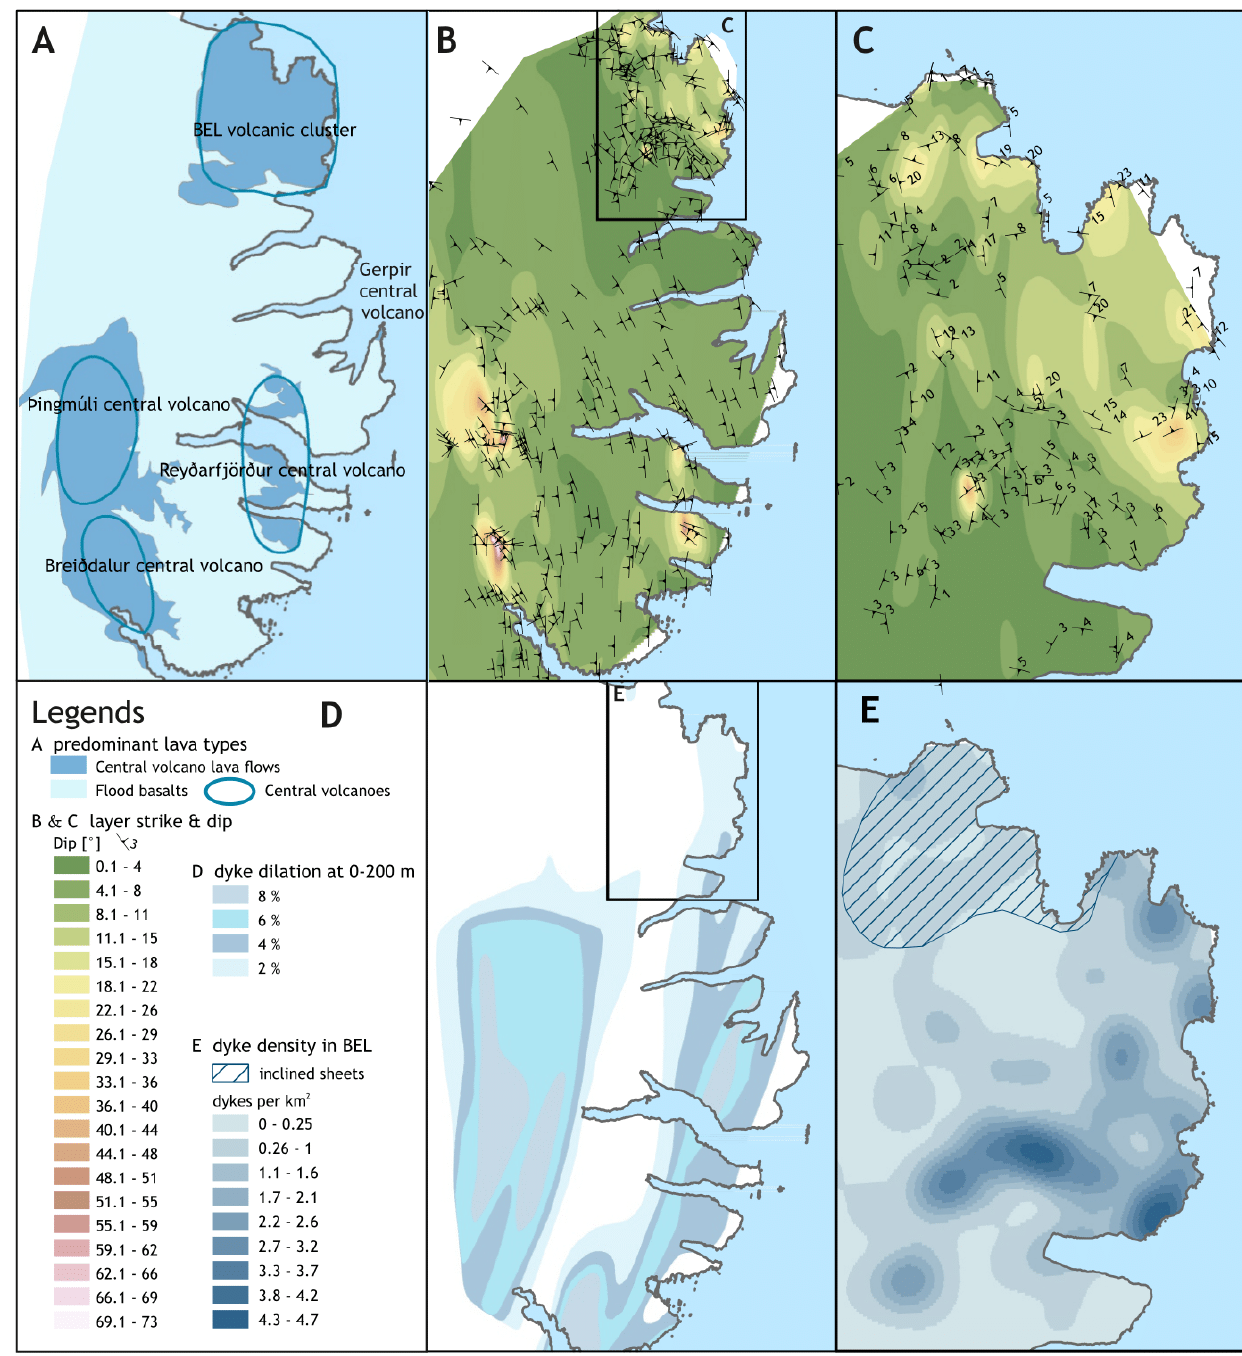
Figure 2: Overview maps of eastern Iceland including Borgarfjörður eystri and Loðmundarfjörður (BEL). [A] Distri- bution of lava flows by type morphology. [B] Strike and dip of the strata in eastern Iceland. Note the anomalies in dip directions that occur around the central volcanoes. [C] A close-up of the BEL area showing the distribution of strata attitude. [D] Map showing dyke dilation at 0–200 m, associated with the occurrence of dyke swarms. [E] A close-up of the dyke density in the BEL